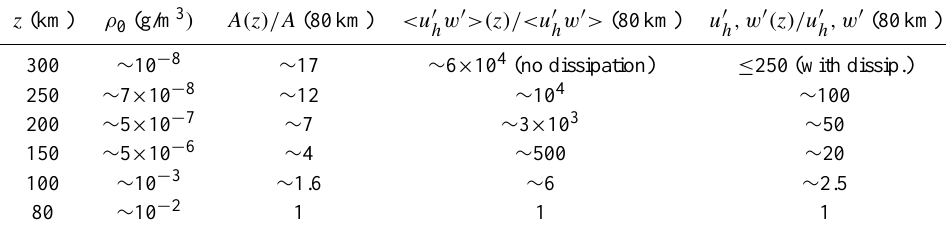
Table 1. Variations with altitude of mean density, ρ 0 (z) , the areas over which momentum fluxes for a specific GW are distributed, A(z) , and the ratios of momentum flux and perturbation velocities for each GW, at thermospheric altitudes of 100, 150, 200, 250, and 300km and a temperature of ∼ 1000K. Values refer only to those GWs that attain the highest altitudes, and the momentum fluxes and velocities at 300km vary somewhat due to differential dissipation among the various GWs that reach these